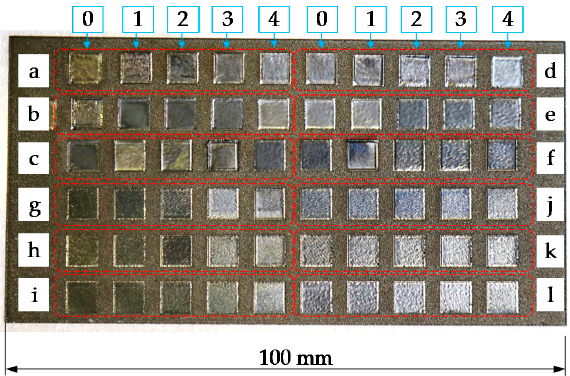
Figure 4. Parameter tests for obtaining the best LP conditions (Test Part 2).